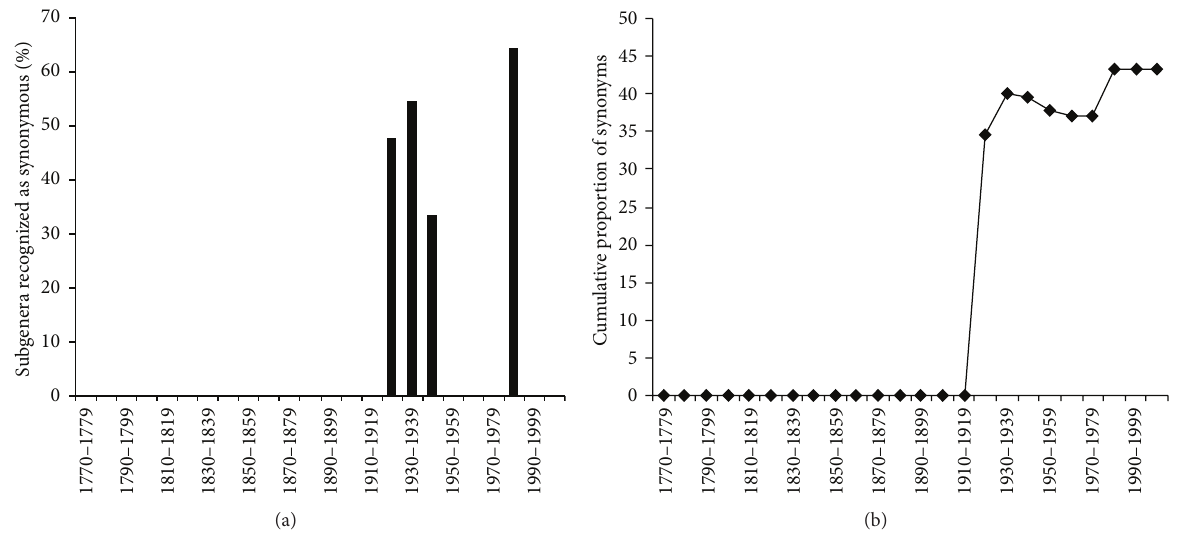
Figure 9: Percentage of synonymous subgenera described in each decade (a) and historical process of accumulation of percentage of synonyms over the total number of names in the Paussini, according to the date of their description (b).